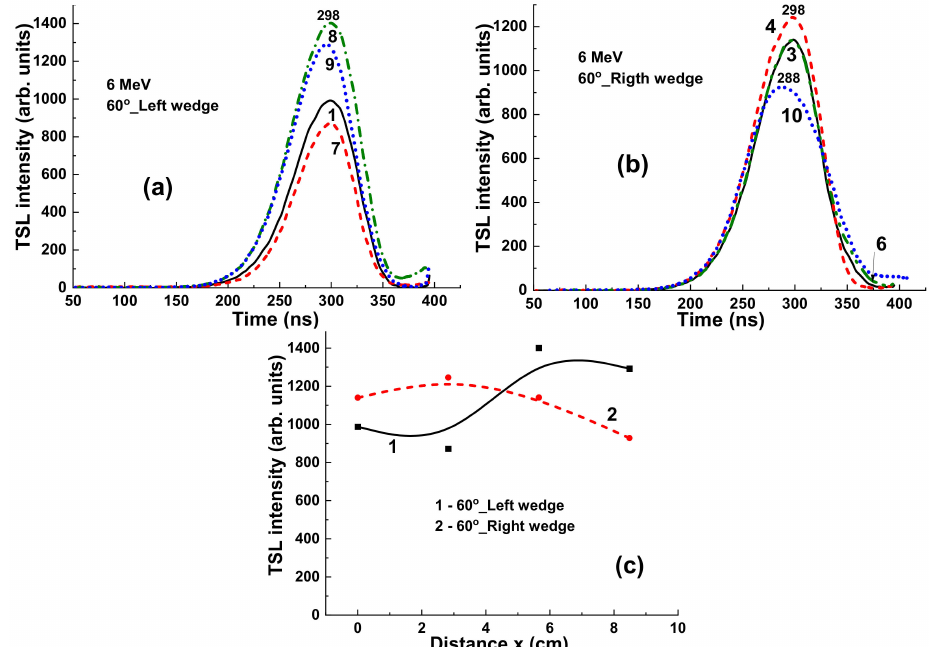
Figure 14. ( a , b ) TSL glow curves for YAG:Ce crystal detectors irradiated by 15 MV X-ray photons from a Clinac 2300 accelerator in the case of using additional wedges 60o_Left ( a ) and 60o_R-right ( b ); ( c ) dependence of the intensity of TSL peaks on distance x between sample and center of target (see Figures 1 and 9).